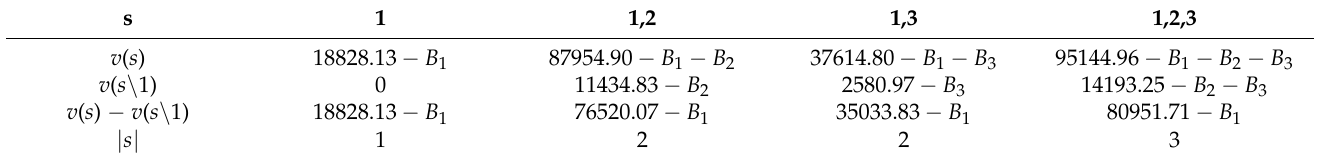
Table 2. Blue carbon cooperation game revenue distribution table of China, Indonesia, and Malaysia.